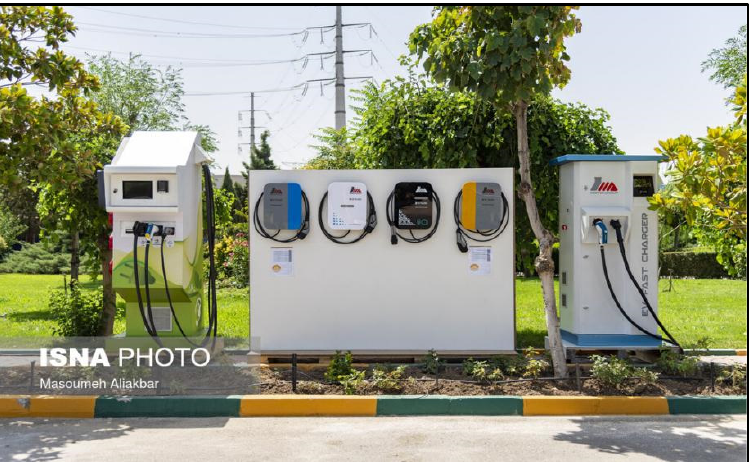
Figure 4. A PV-based charging station for EVs in Tehran, Iran [Photo by ISNA News Agency] [41].